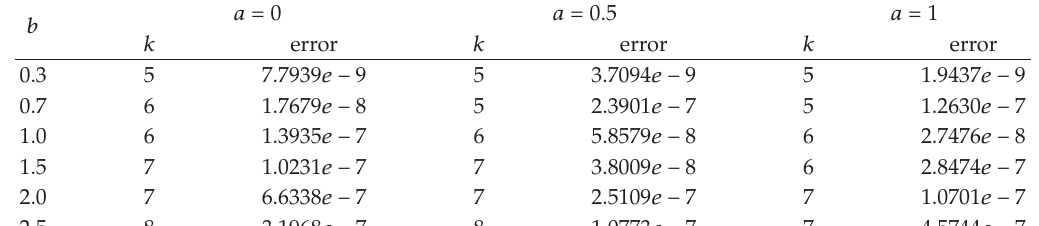
Table 8: Convergence of the method in Example 4.5 for grid 129 × 129.